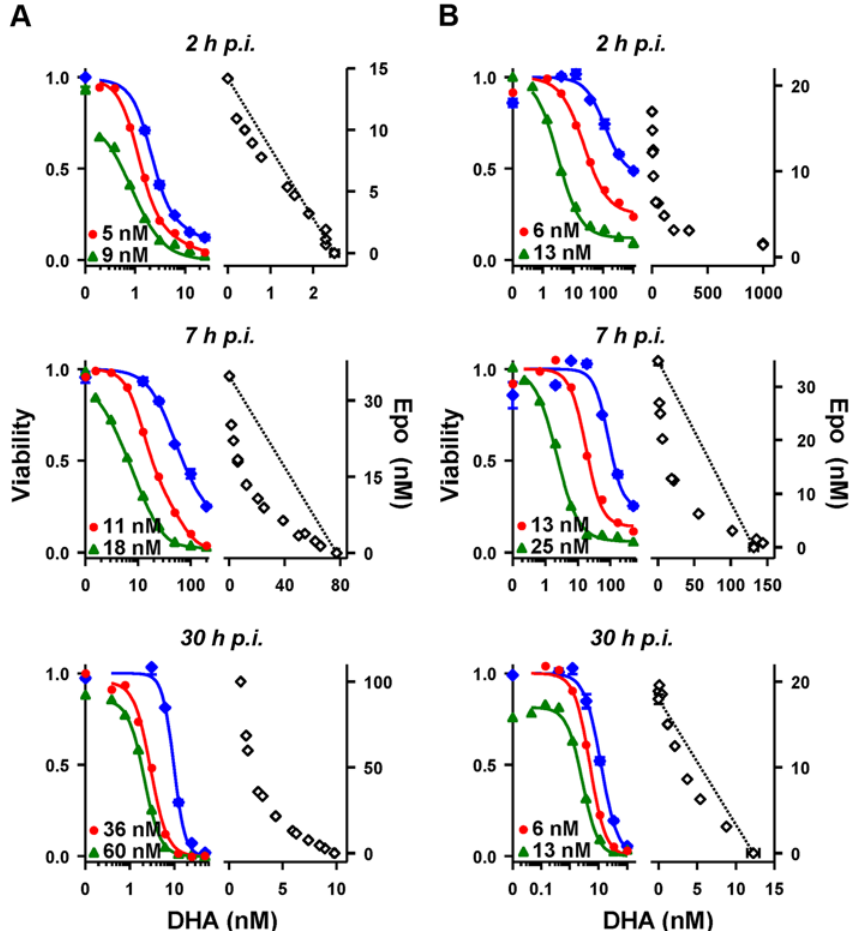
Fig 5. Synergy of DHA and a proteasome inhibitor against P . falciparum . The interaction of DHA and epoxomicin (Epo) was examined using (A) 3D7 and (B) PL1 parasites at the ages indicated. Left panels in (A and B) show the dose-responses to DHA (blue symbols) and the influence of sublethal concentrations (indicated) of epoxomicin. Right panels in (A and B) show isobolograms for the epoxomicin-DHA pair at the 50% LD 50 (3h) level. The dashed line is plotted between the LD 50 (3h) of each drug when used alone, emphasizing the concave nature of many of the isobolograms. The absence of a dashed line indicates the LD 50 (3h) value of one of the drugs was outside the range of concentrations examined. Error bars, where present, correspond to the range of duplicates.